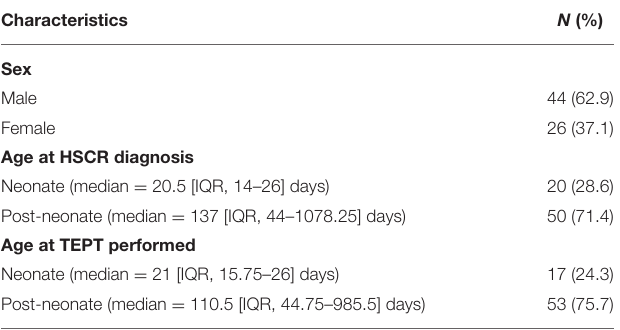
TABLE 2 | HAEC findings in patients with HSCR after TEPT using different cut-off